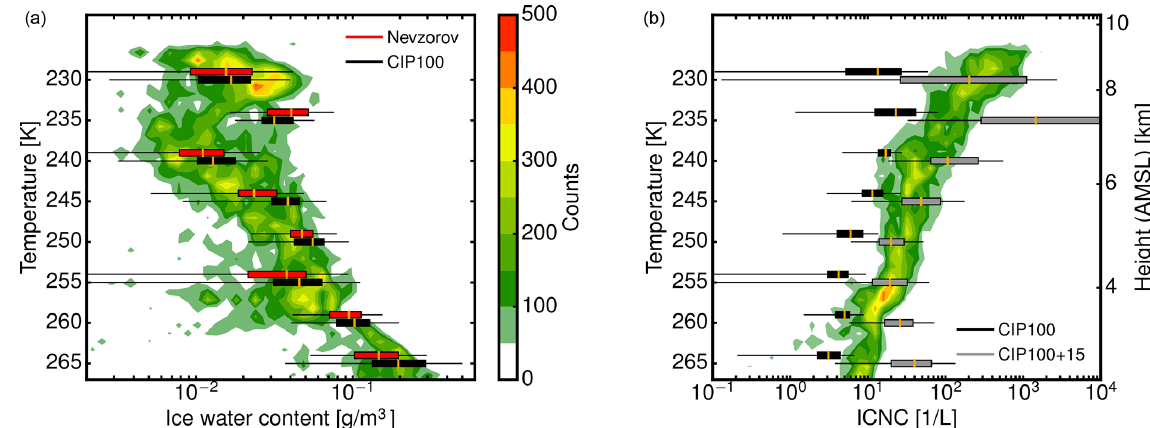
Figure 10. Comparison of VarCloud results derived from HALO measurements with in situ measurements on board the BAe-146 for the joint flight leg. (a) Retrieved ice water content (contour) against Nevzorov hot-wire (red boxplot) and CIP-100 (black boxplot) probe measure- ments. (b) Retrieved ice crystal number concentration (contour) against the composite measurement of CIP-15 and CIP-100 (gray boxplot) and CIP-100 (black boxplot)